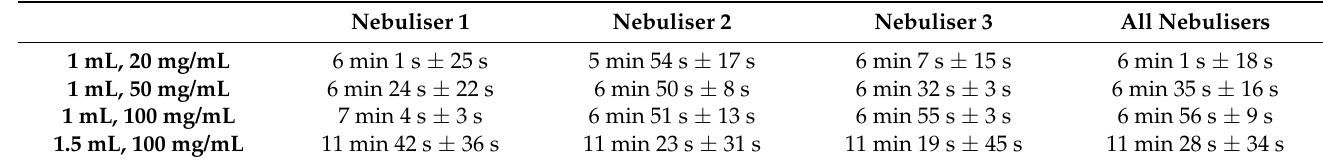
Table 5. Nebulisation duration of the laser diffraction experiments.